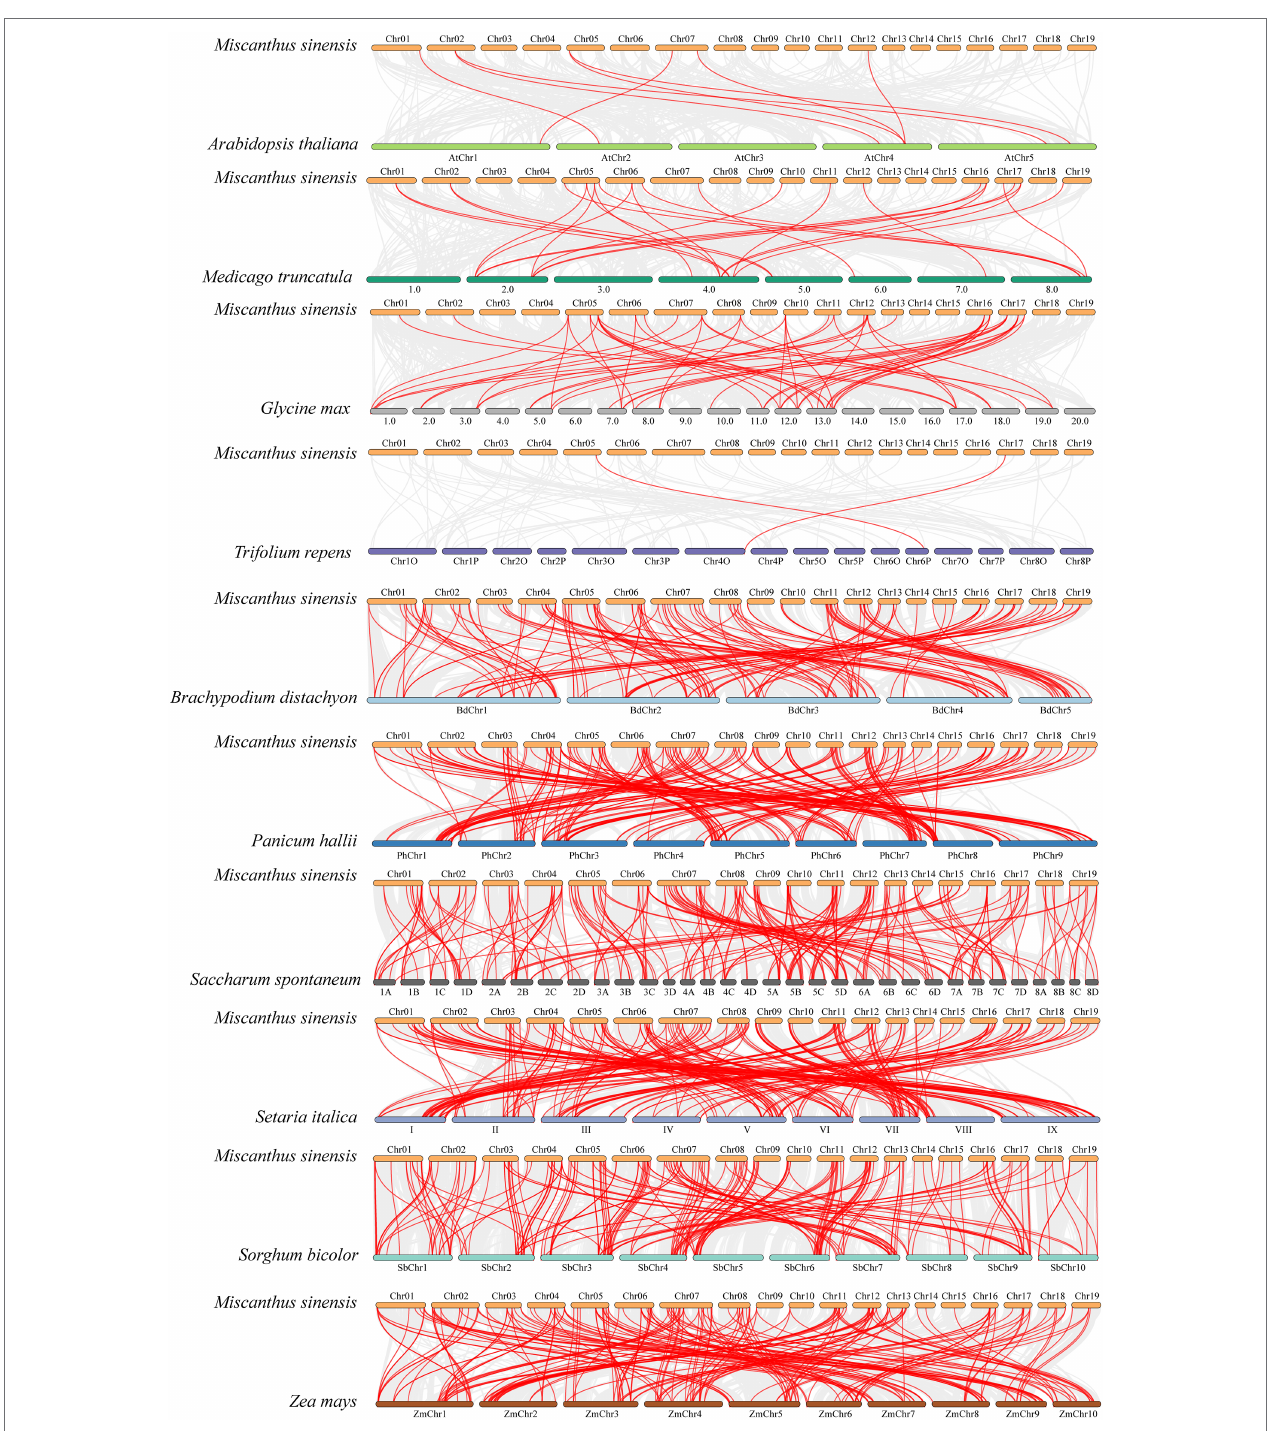
FIGURE 5 | Synteny analysis of NAC genes between M. sinensis and 10 representative plant species. Gray lines in the background indicate the collinear blocks within the M. sinensis and other plant genomes, whereas the red lines highlight the syntenic NAC gene